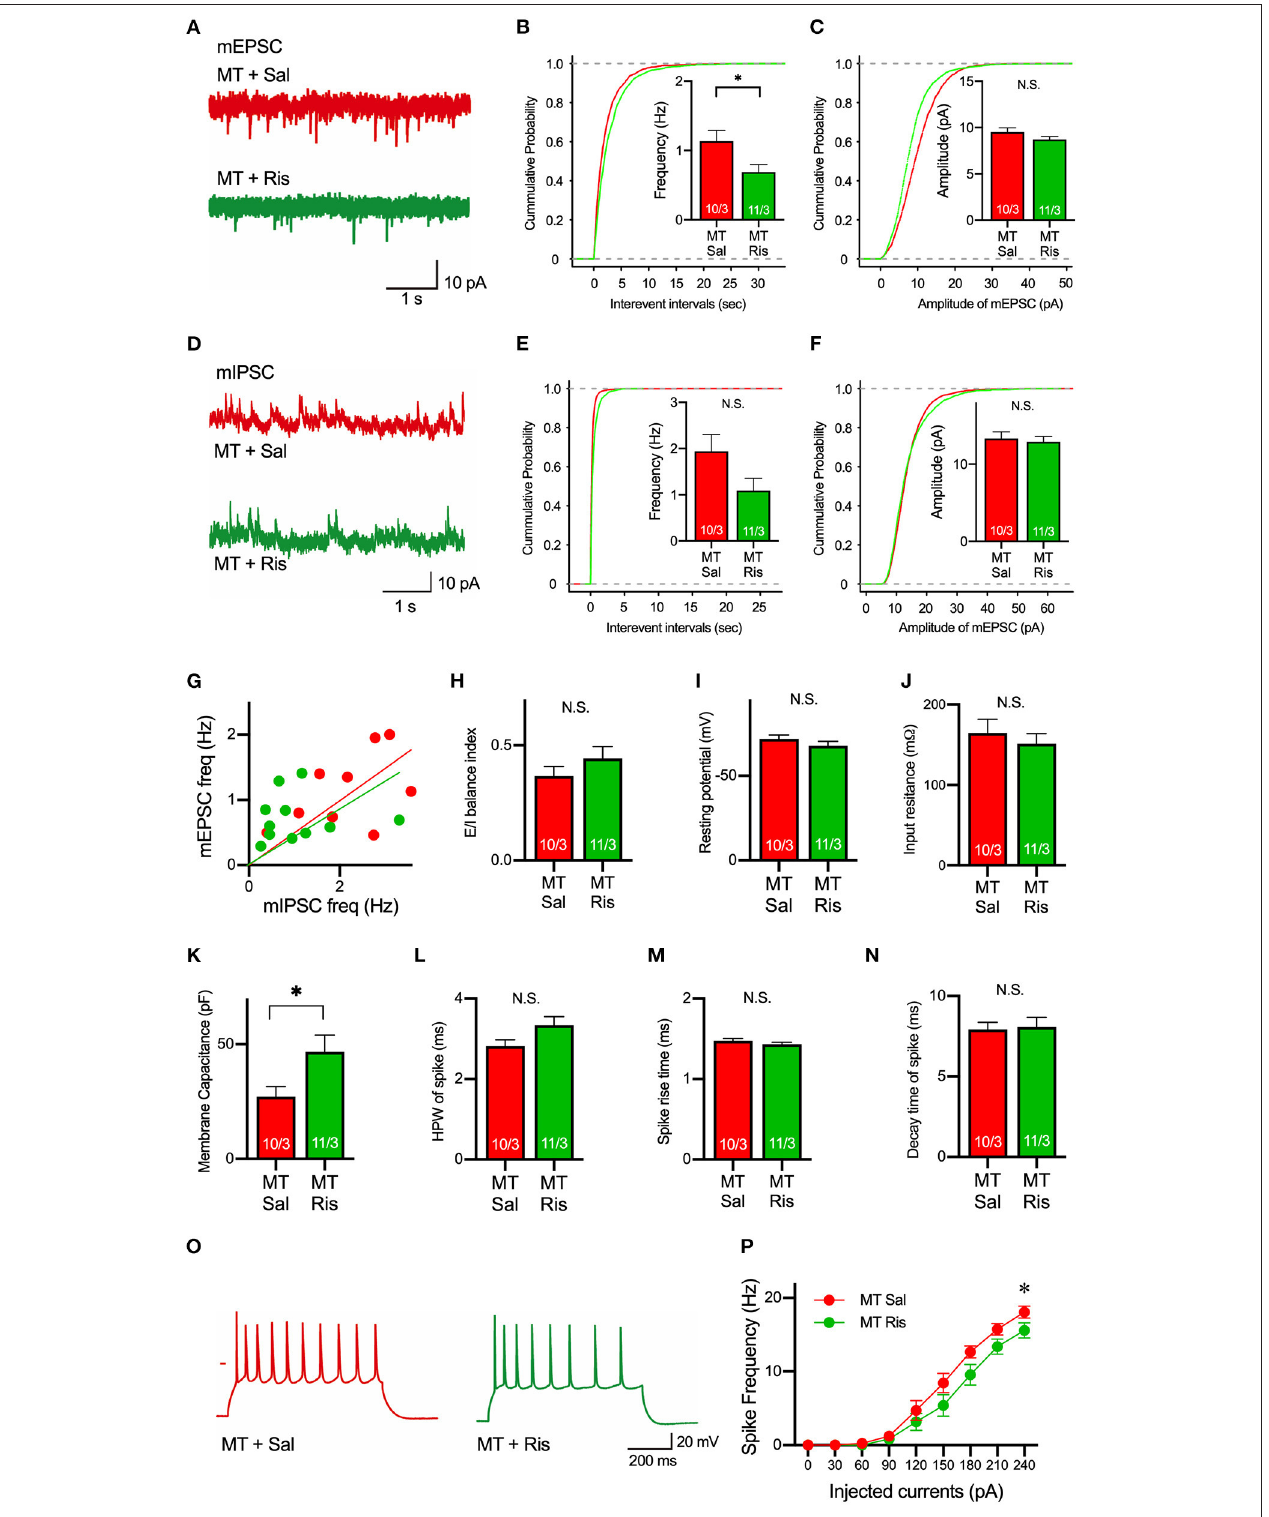
FIGURE 5 | Risperidone reduces frequencies of mEPSCs and action potentials in the SIK1-MT mice. (A) Representative traces of mEPSC recorded from pyramidal neurons in layer 5 of the mPFC in saline (Sal)- or risperidone (Ris)-injected SIK1-MT mice. (B) Cumulative distribution of inter-event intervals and the mean values of